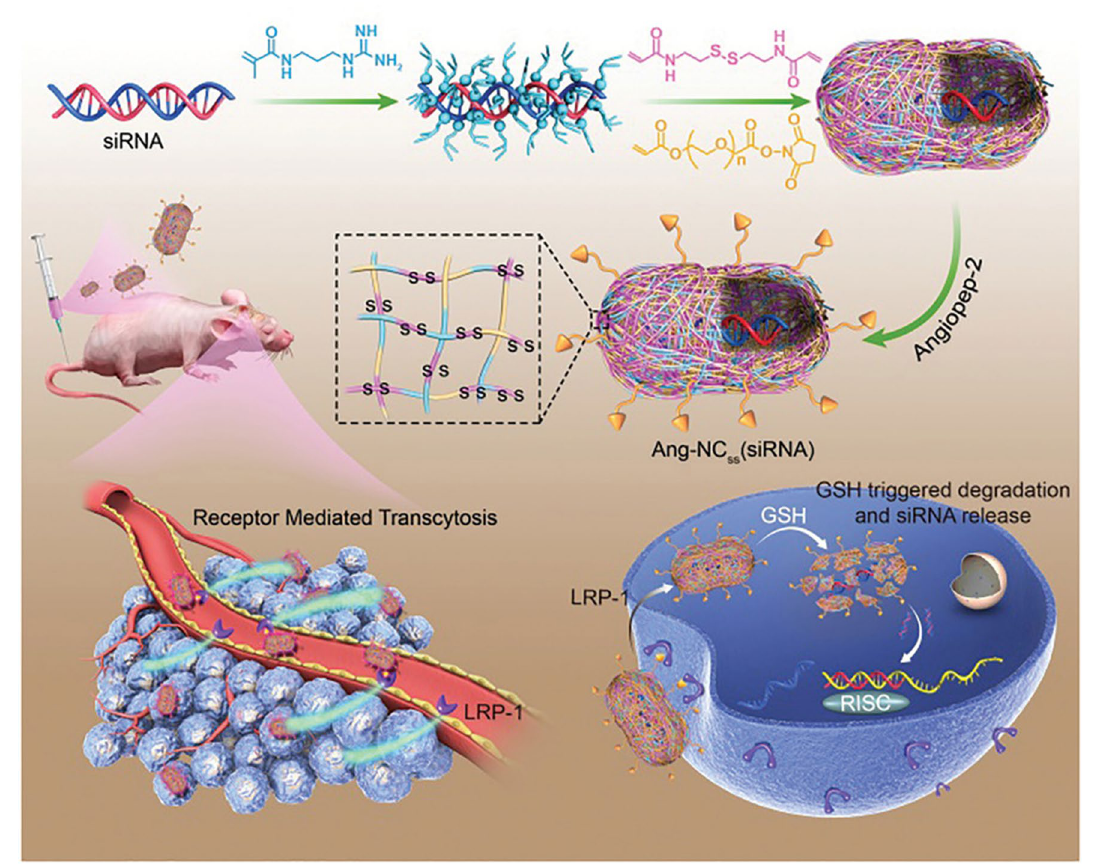
Fig. 6 Illustration of Ang-NCss(siRNA) nanocapsule preparation, efficient BBB penetration, highly specific GBM targeting, responsive drug release, and gene silencing [161]. Copyright 2020, Wiley–VCH